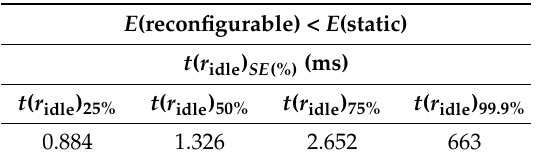
Table 4. The energy-saving ratios that refer to the reconfigurable case against the static version. The value t ( r idle ) indicates the minimum time required by the black box to save a quantity of SE ( % ) energy equal to the saving factor in